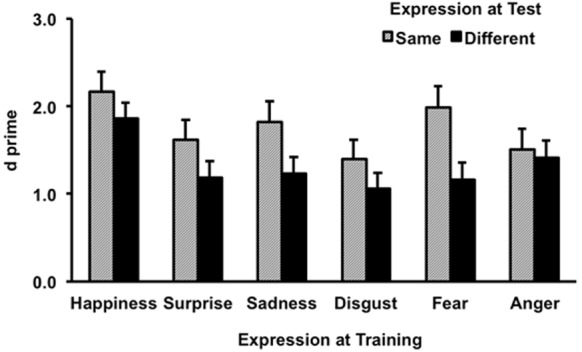
Sensitivity results as a function of trained and tested expression. Error bars represent one standard error above the means.